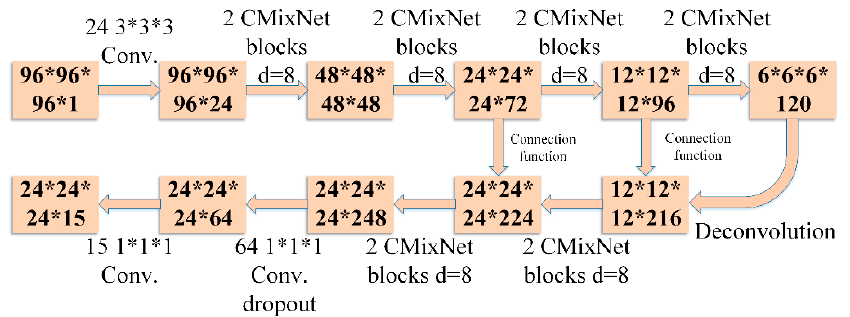
Figure 6. Feature extraction using CMixNet with U-Net-like encoder–decoder architecture for nodule detection. The numbers in the boxes represent the sizes of the feature maps in the sequence #slices, #rows, #cols, and #maps. The numbers outside the boxes are in sequence #filters, #slices, #rows, and #cols.